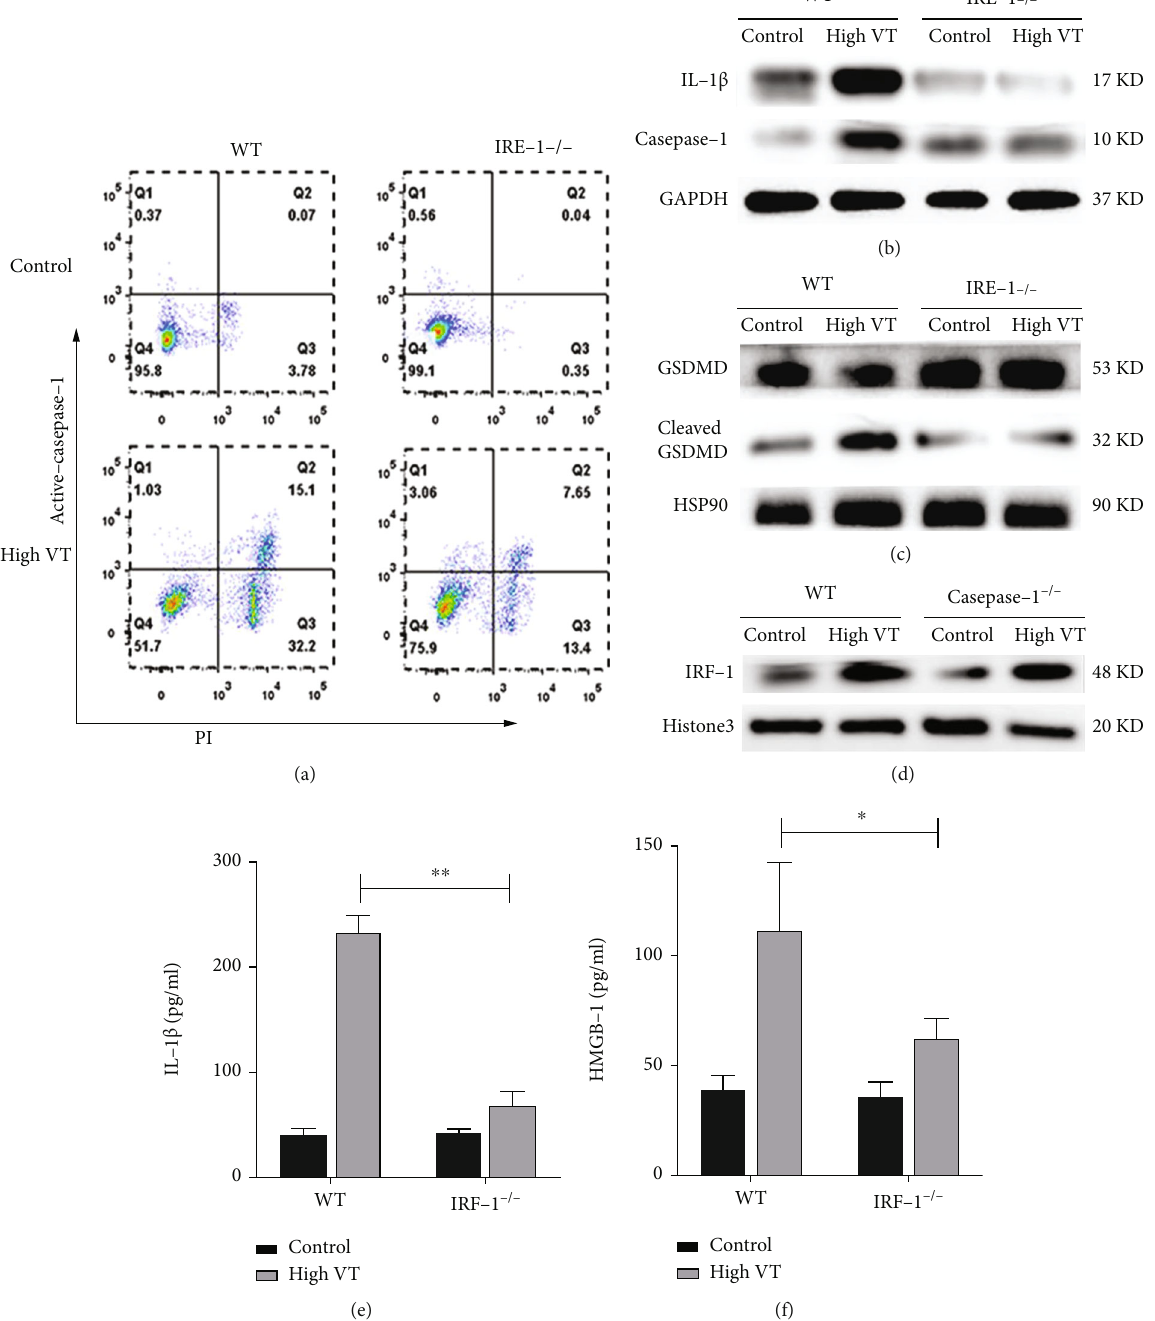
Figure 5: IRF-1 was required for caspase-1 activation in AMs. The fl ow cytometry showed IRF-1 deletion attenuated alveolar macrophage pyroptosis in high VT (a). Western blotting analysis of protein expression of caspase-1 p10 (b), IL-1 β (b), and GSDMD including full-length and cleaved forms (c) in alveolar macrophages. Analysis of IRF-1 protein levels (d) in the nucleus of alveolar macrophages indicated that caspase-1 deletion did not a ff ect expression of IRF-1. The concentration of IL-1 β (e) and HMGB-1 (f) in BALF was attenuated after high VT with IRF-1 deletion compared to that wild type. Results are representative of three independent experiments; the results of one representative experiment are shown ( n = 5 /group, ∗ p < 0 : 05 , ∗∗ p < 0 : 01